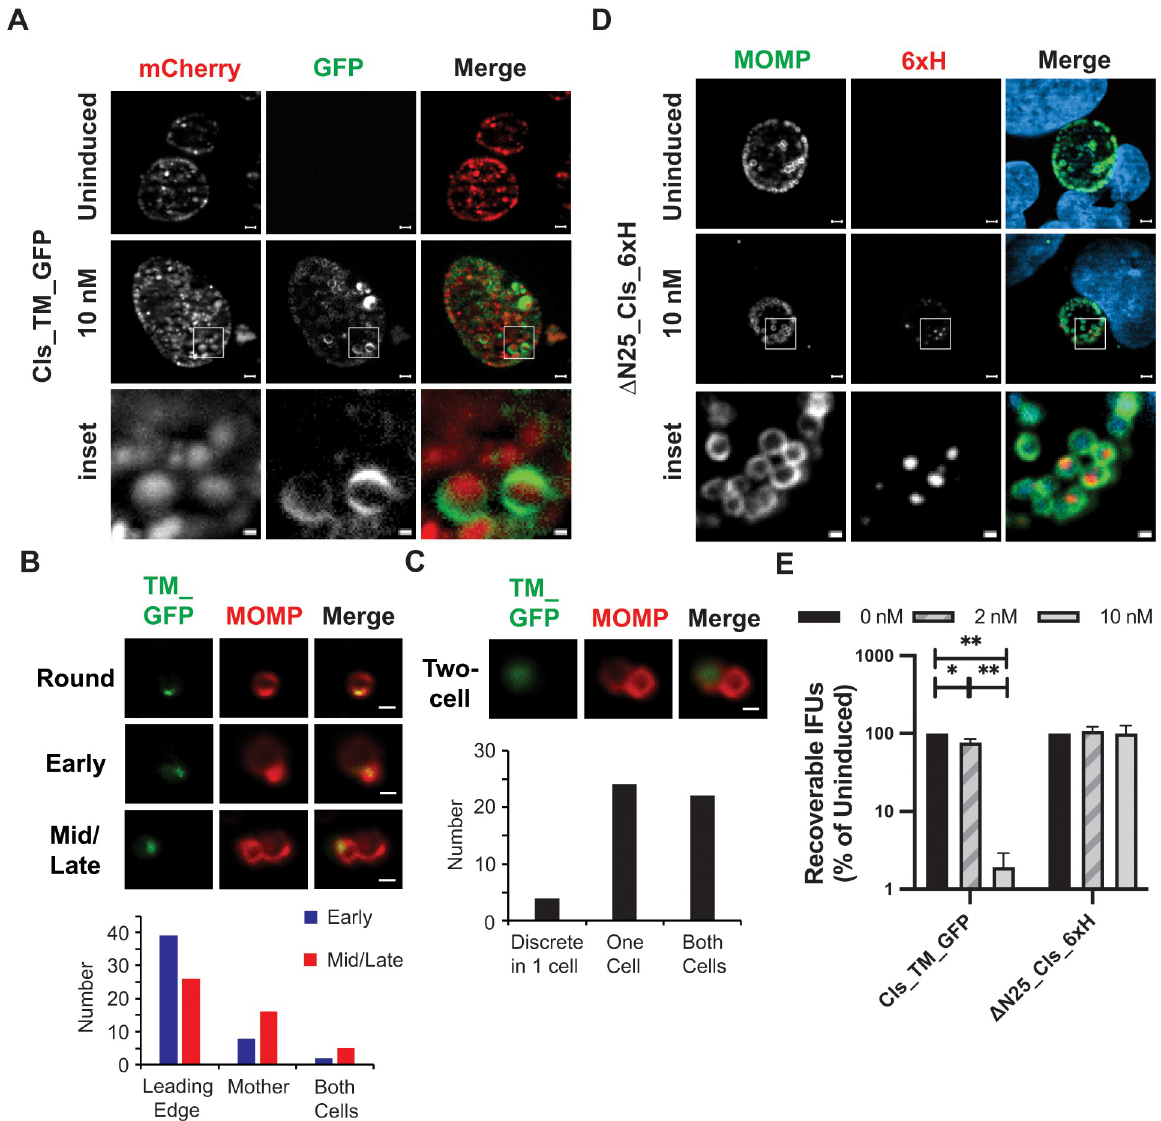
Fig 3. Functional evaluation of the Cls transmembrane (TM) domain in directing protein localization. (A) C . trachomatis L2 was transformed with an anhydrotetracycline (aTc) inducible vector encoding the Cls TM domain (first 25 residues) fused to GFP; mCherry encoded on the plasmid backbone is constitutively expressed. Cells were infected with this strain, and expression of Cls_TM_GFP was induced or not at 15hpi with 10nM aTc. Localization of the marker and mCherry in live-cell images acquired at 19hpi is shown. (B) The localization of Cls_TM_GFP at Round, Early, and Mid/Late stages of division or (C) the two-cell stage of division was imaged and quantified from transformants induced in axenic media. For (B) Cls_TM_GFP was localized to a polar cluster in round cells and primarily at the leading edge of the budding daughter cells, whereas for (C) it was localized as a discrete patch in one cell or diffuse in one or both cells. At least 50 cells were counted for each stage of division. Images in B and C were acquired with a Zeiss AxioImager2 microscope equipped with a 100x oil immersion PlanApochromat lens. Scalebar in panels B and C = 2 μ m. (D) Cells were infected with C . trachomatis L2 transformed with an aTc-inducible vector encoding Cls_6xH lacking the TM domain (i.e. starting at residue 26). Expression of the construct was induced or not at 4hpi, and samples were fixed and processed at 24hpi as described in the legend to S3 Fig. For (A) and (D) the boxed region within each image is shown below as an enlarged inset. Note the discrete localization pattern to one side of the bacterial membrane in (A) but not in (D). Images in A and D were acquired on a Zeiss AxioImager. Z2 equipped with an Apotome2 using a 100X lens objective. Images are representative of at least three independent experiments. Scalebar of full inclusion images in A and D = 2 μ m; Scalebar of inset = 0.5 μ m (E) Cells were infected with the indicated transformants and processed as described in the legend to S3 Fig to quantify IFU production during the primary infection. For each transformant, the uninduced values were arbitrarily set to 100%, and the effect of overexpression induced by 2nM or 10nM aTc added at 4hpi is expressed as a percentage of the uninduced control. Data are the average of three independent experiments performed in triplicate. � = p < 0.05; �� = p < 0.001.